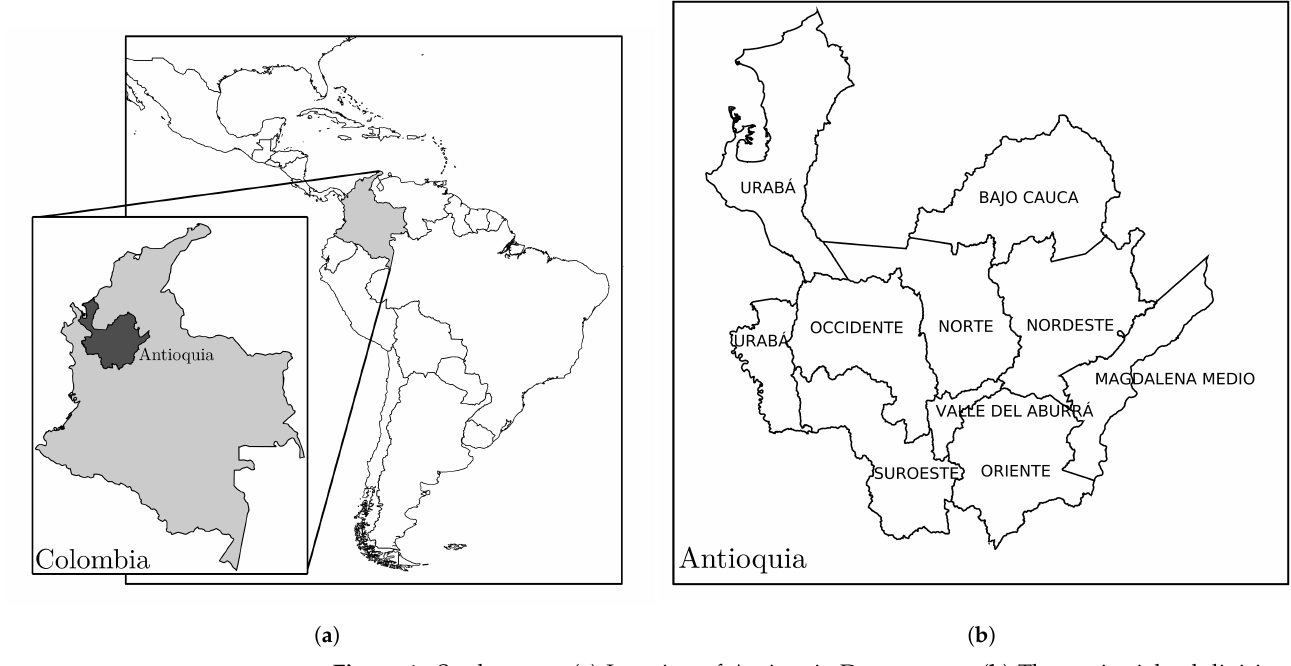
Figure 1. Study zone. ( a ) Location of Antioquia Department. ( b ) The territorial subdivision of Antioquia consists of nine subregions that have a high geographic diversity; see Table 1 for further information about each